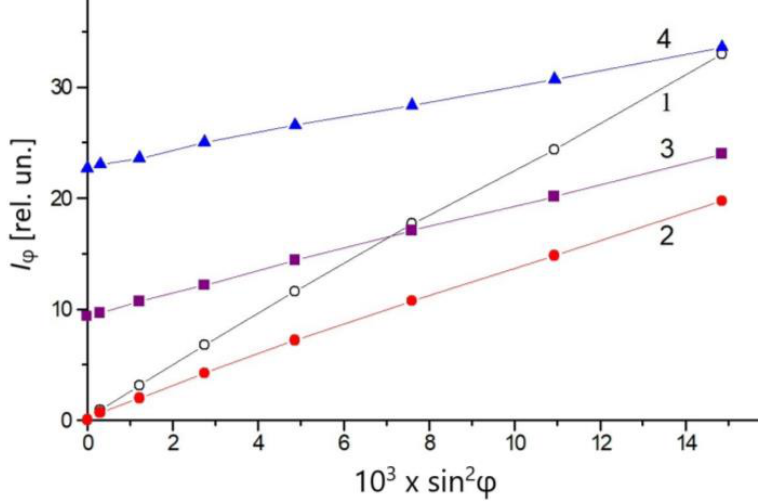
Figure 3. Dependence of the intensity I φ of the transmitted light with a wavelength of 650 nm on the angle of decrossing φ (degrees) in the aqueous suspension of PM and in composite agarose gels with incorporated PM in equal concentrations: 1 — PM in bidistilled water; 2 — PM in fresh 0.3% gel; 3 — PM in fresh 0.4% gel; and 4 — PM in fresh 0.6% gel.